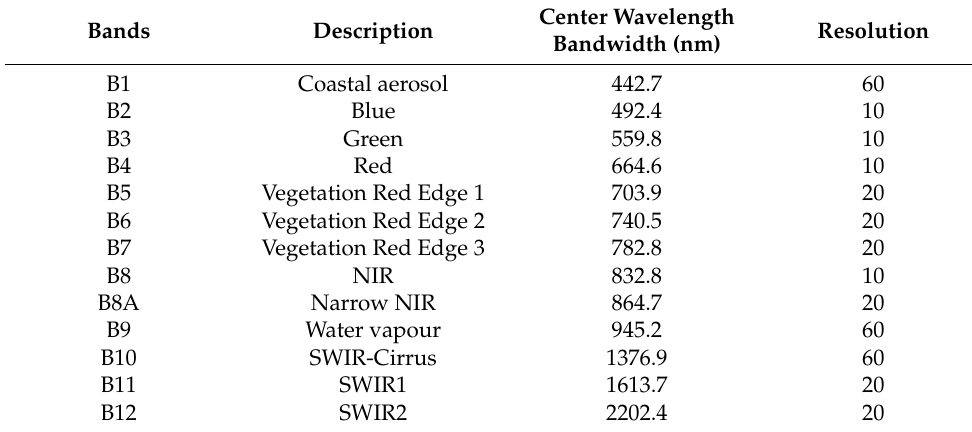
Table 1. Main band parameters of Sentinel-2 data.